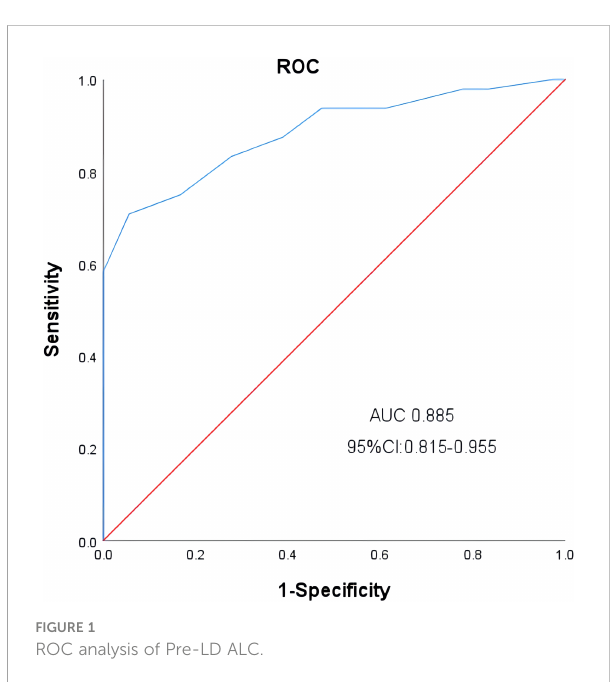
FIGURE 1 ROC analysis of Pre-LD